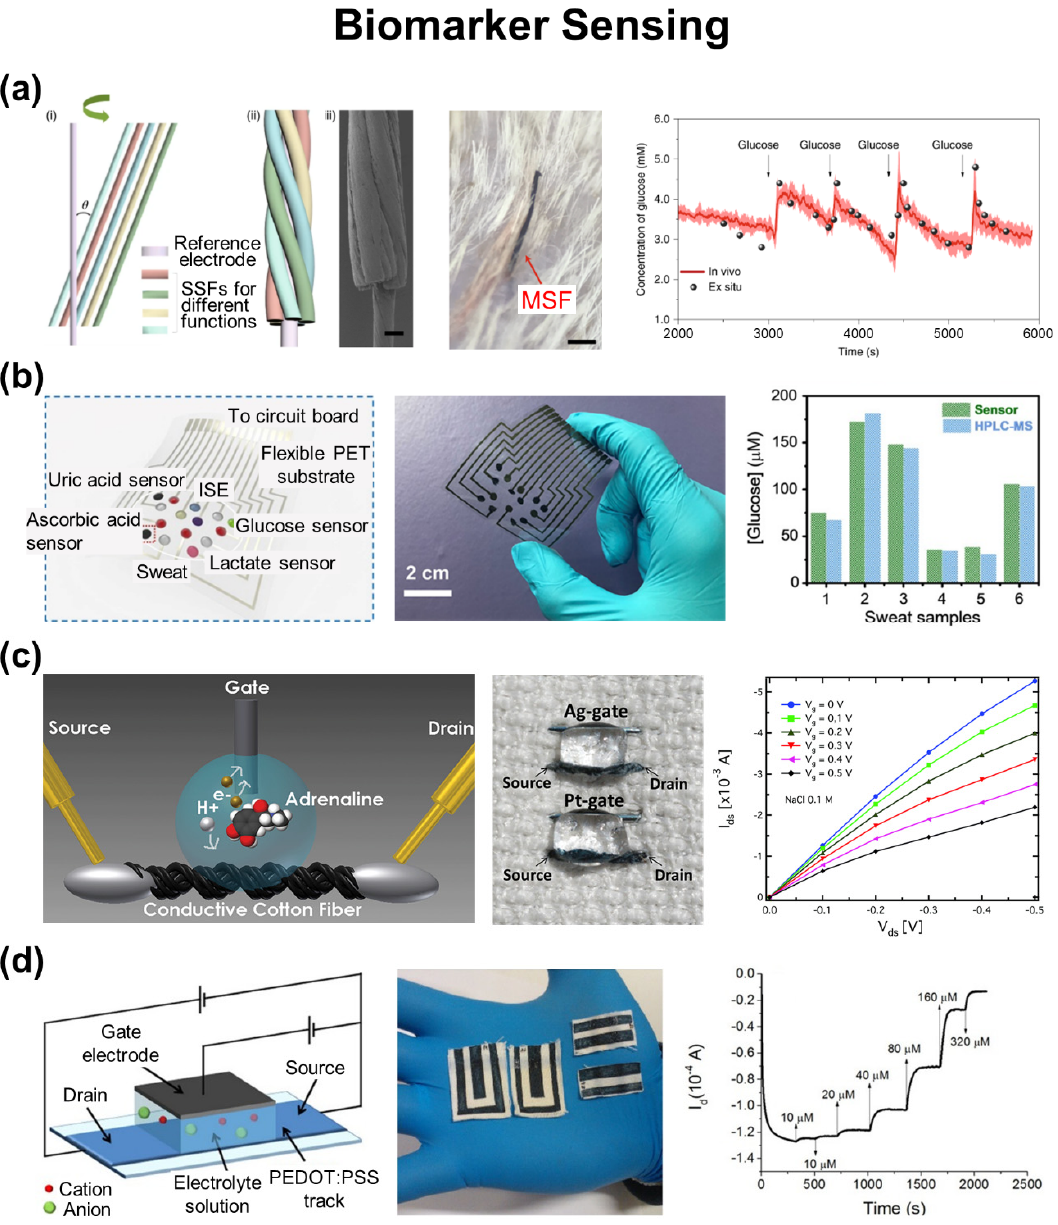
Figure 4. E-textiles for biomarker sensing. ( a ) Multi-ply electrochemical sensing fiber (MSF) with helical CNT bundles. Reprinted with permission from [110]. Copyright 2019 Springer Nature. ( b ) Electrochemical SilkNCT-based wearable sweat analysis patch. Reprinted with permission from [112]. Copyright 2019 American Association for the Advancement of Science. ( c ) OECTs fiber with PEDOT:PSS. Reprinted with permission from [113]. Copyright 2014 Royal Society of Chemistry. ( d ) OECTs fabric with PEDOT:PSS. Reprinted with permission from [114]. Copyright 2016 Springer Nature.